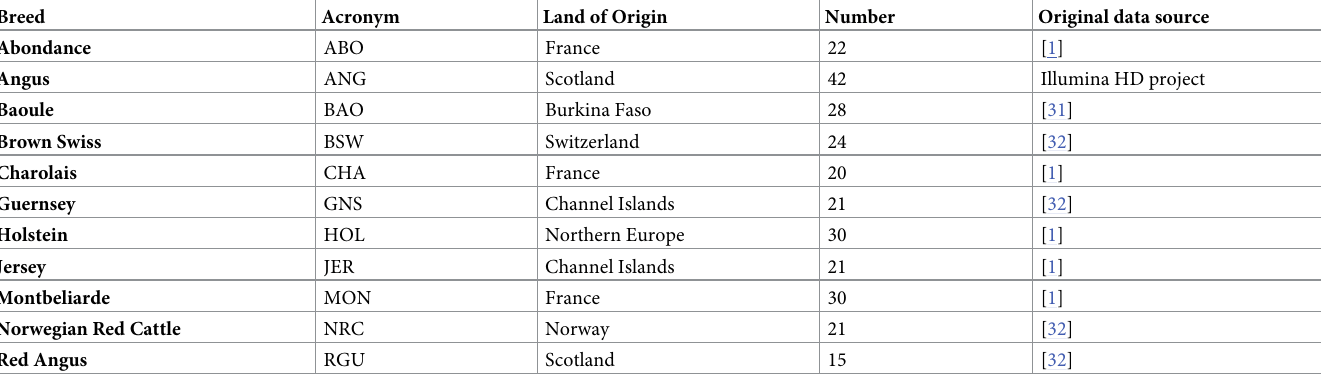
Table 1. Description and source of publicly available outgroup data on 274 individuals across 11 breeds.